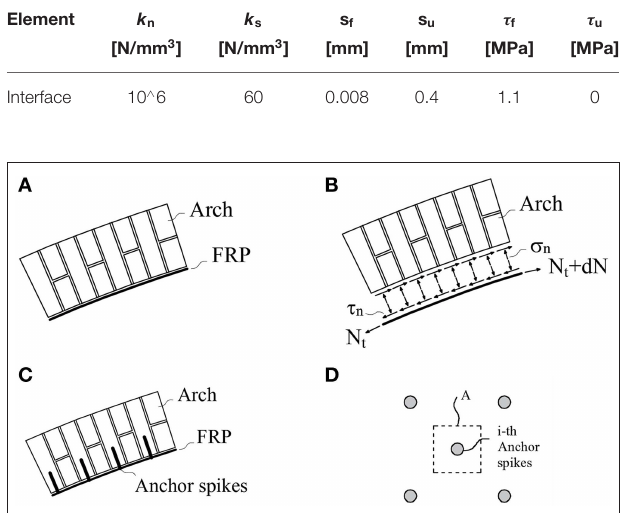
FIGURE 10 | (A) Arch FRP strengthening, (B) normal and tangential stress distribution between FRP and masonry substrate, (C) lateral view of spike anchors, (D) influence area of the i-th spike